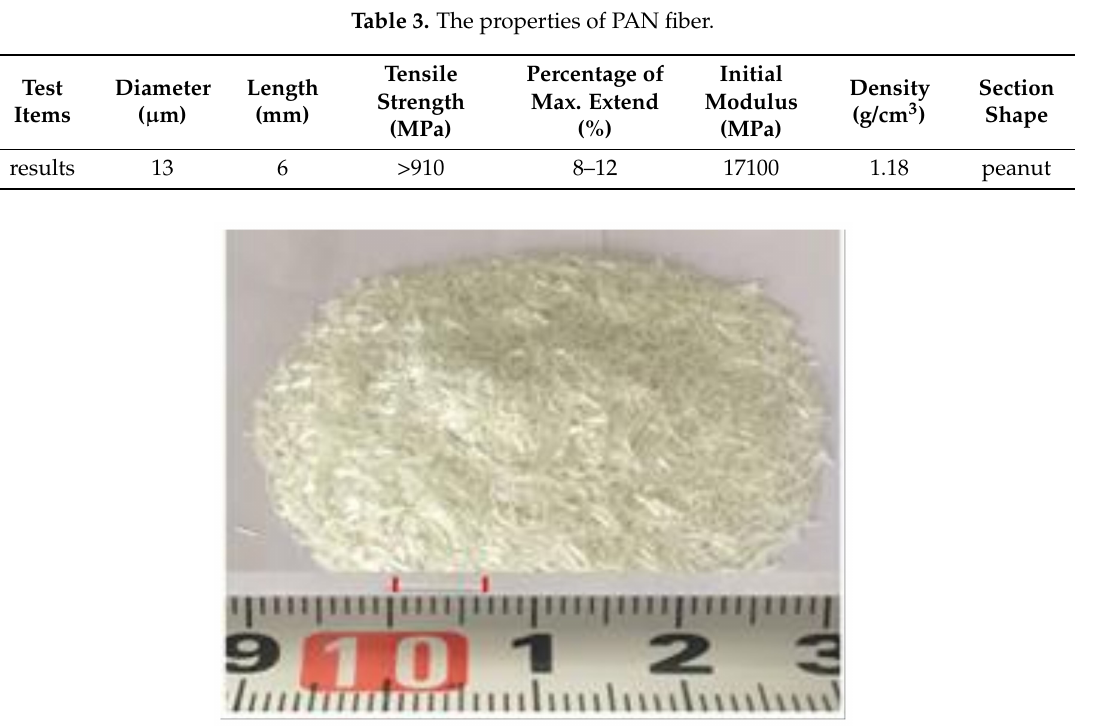
Figure 2. View of PAN